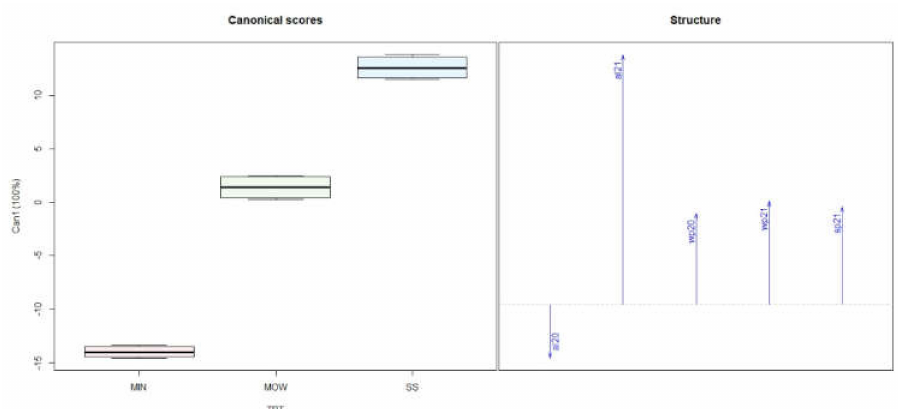
Figure 4. Discriminant canonical analysis of nutrient concentration sampled in summer and autumn of 2020 and 2021. Since no significant difference between years was observed, data from both years were pooled together. Bar charts (left) of discriminant functions and arrows on the right side represent the direction of each parameter analyzed.